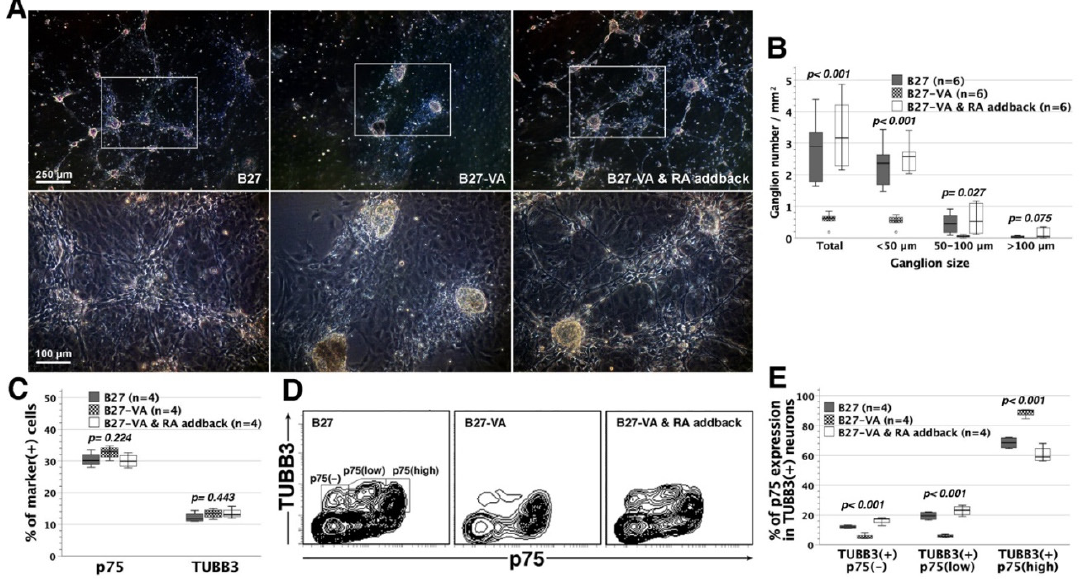
Figure 4. The effects of vitamin A derivatives on neuronal differentiation and wiring. As a modified version of the original B27 without vitamin A (retinyl acetate), B27 minus vitamin A (group B27-VA)